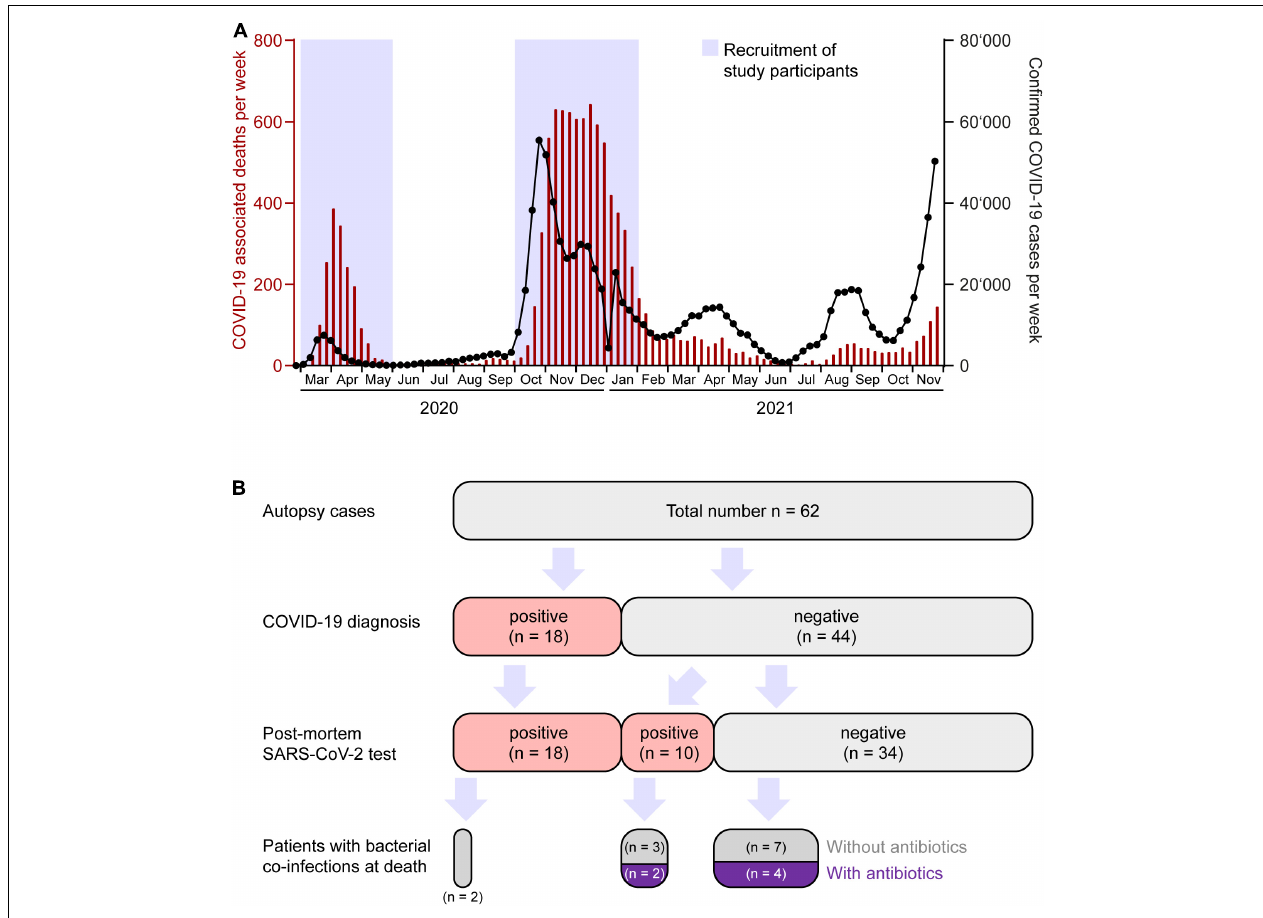
FIGURE 1 | Coronavirus disease 2019 (COVID-19) epidemiology and stratification of patients. (A) Weekly numbers of COVID-19 cases (black interconnected dots, right axis) and deaths (red bars, left axis) in Switzerland from March 2020 until November 2021. Blue boxes represent time windows for collection of consecutive autopsies. Source of data: Bundesamt für Gesundheit (BAG) Switzerland, December 12, 2021. (B) Partition of autopsy cohort according to COVID-19 diagnosis, SARS-CoV-2 infection, co-infection, and antibacterial